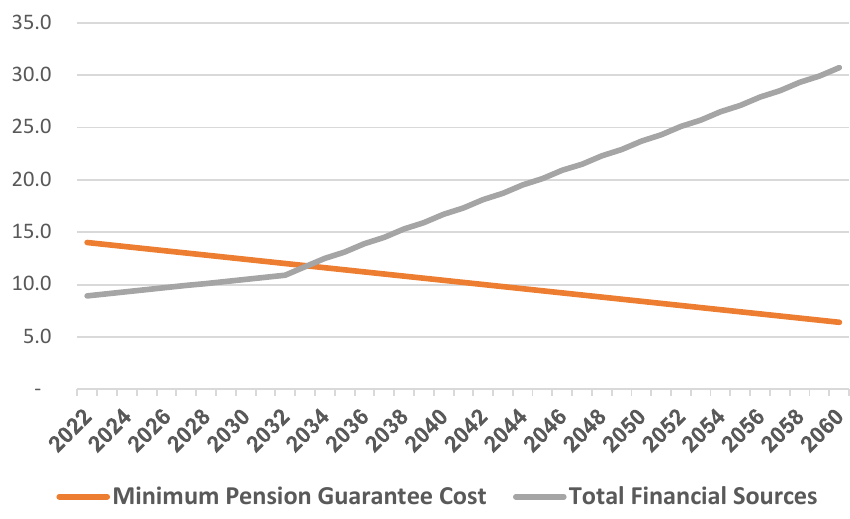
Figure 4. Financing Minimum Pension Guarantee at Retirement. Source: Authors’ elaborations are based on MOF estimates and the trend of negotiations between the government and security organ- izations.